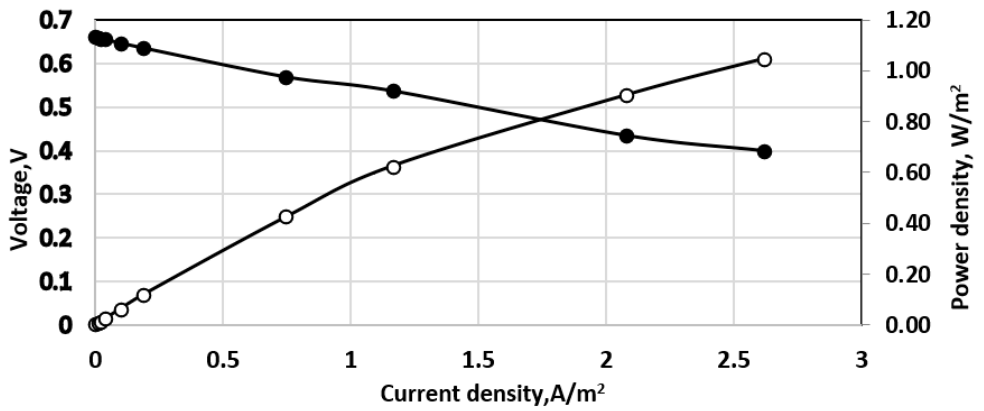
Figure 11. Effect of aeration by Venturi type ejector; 190 mg dm − 3 sulfide solution. Continuous process. Membrane Celgard 3501. Active electrode and membrane area—650 cm 2 . Feed flow rate—0.2 dm 3 /h. Anode volume 800 cm 3 . (•)—cell voltage; ( ○ ) power density; temperature 20 °C.